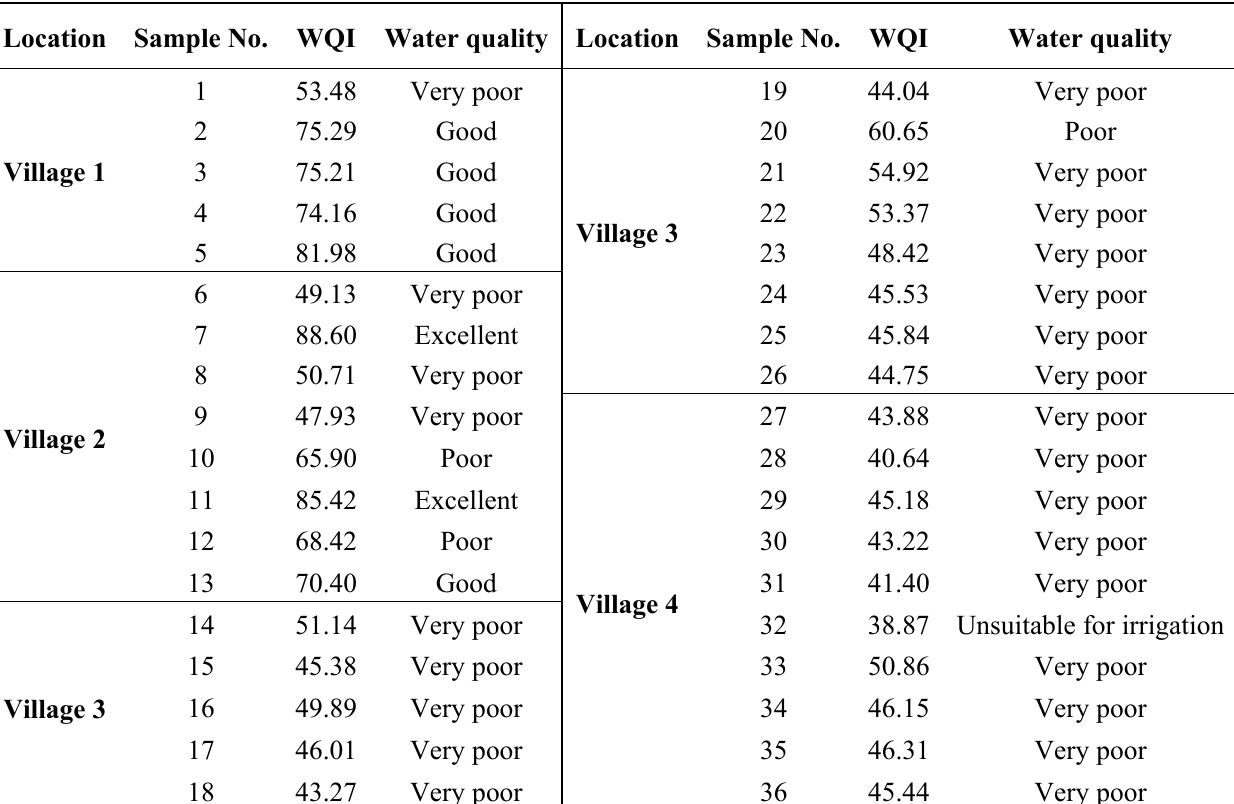
Table 7. Groundwater Quality Index